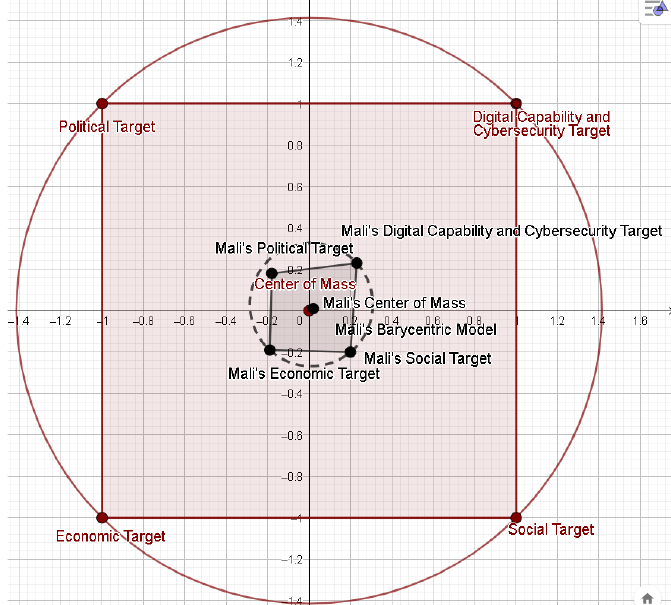
Figure 14. Four–pole barycentric model of balanced development of Mali. Source: Authors’